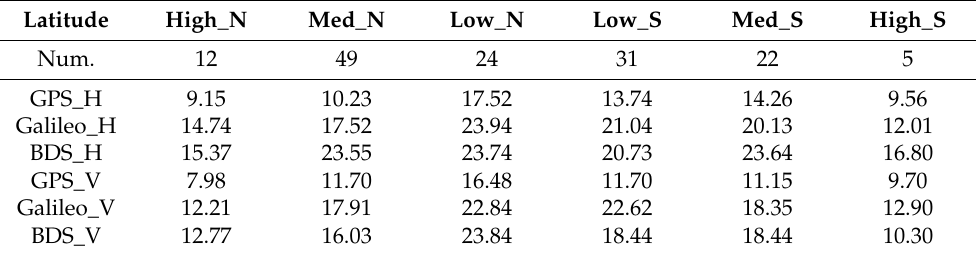
Figure 7. Geographical distribution of the median convergence times of static PPP for the selected 143 worldwide MGEX tracking stations over a month (September 2022) using three single systems. Table 2. The number of stations and the mean convergence times (unit: min) of the different latitudes for static PPP.